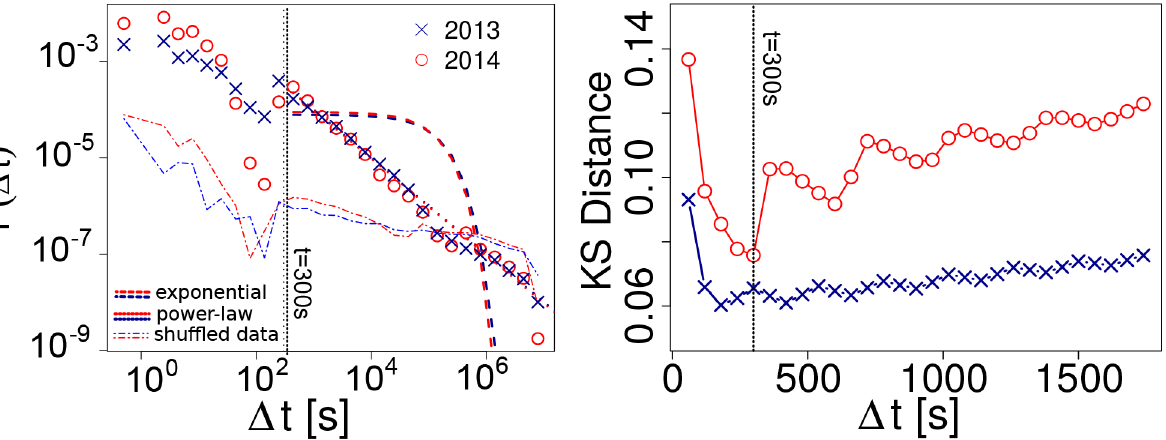
Fig 1. Analysis of time intervals between the appearance of TT. Left: distribution of time intervals, dashed lines show power-law, exponential fits, and distributions for shuffled datasets. Right: KS Distance between the empirical distribution and a power-law fit for ranging values of the minimum Δ t of the